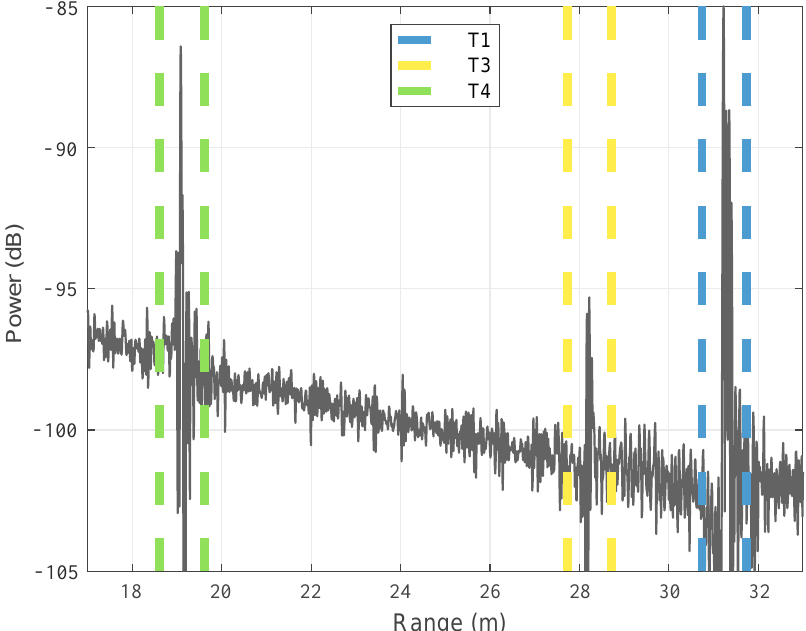
Figure 16. Measured radar diagram of scenario #0 with indicated time gates.